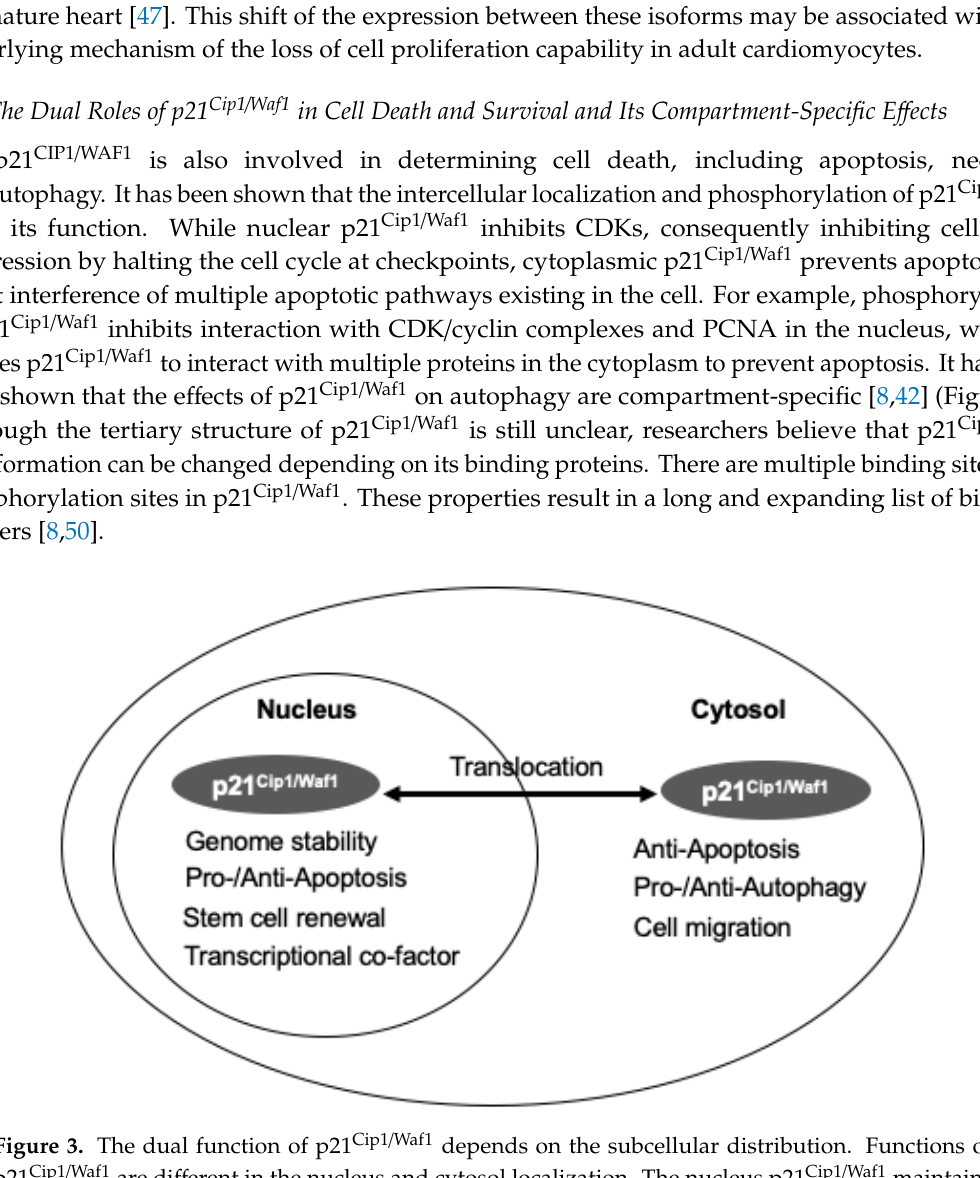
Figure 3. The dual function of p21 Cip1/Waf1 depends on the subcellular distribution. Functions of p21 Cip1/Waf1 are different in the nucleus and cytosol localization. The nucleus p21 Cip1/Waf1 maintains genome stability, regulates apoptosis, involves stem cell renewal, and acts as a transcriptional co- factor, while the cytosol p21 Cip1/Waf1 binds to caspase to inhibit apoptosis and regulate